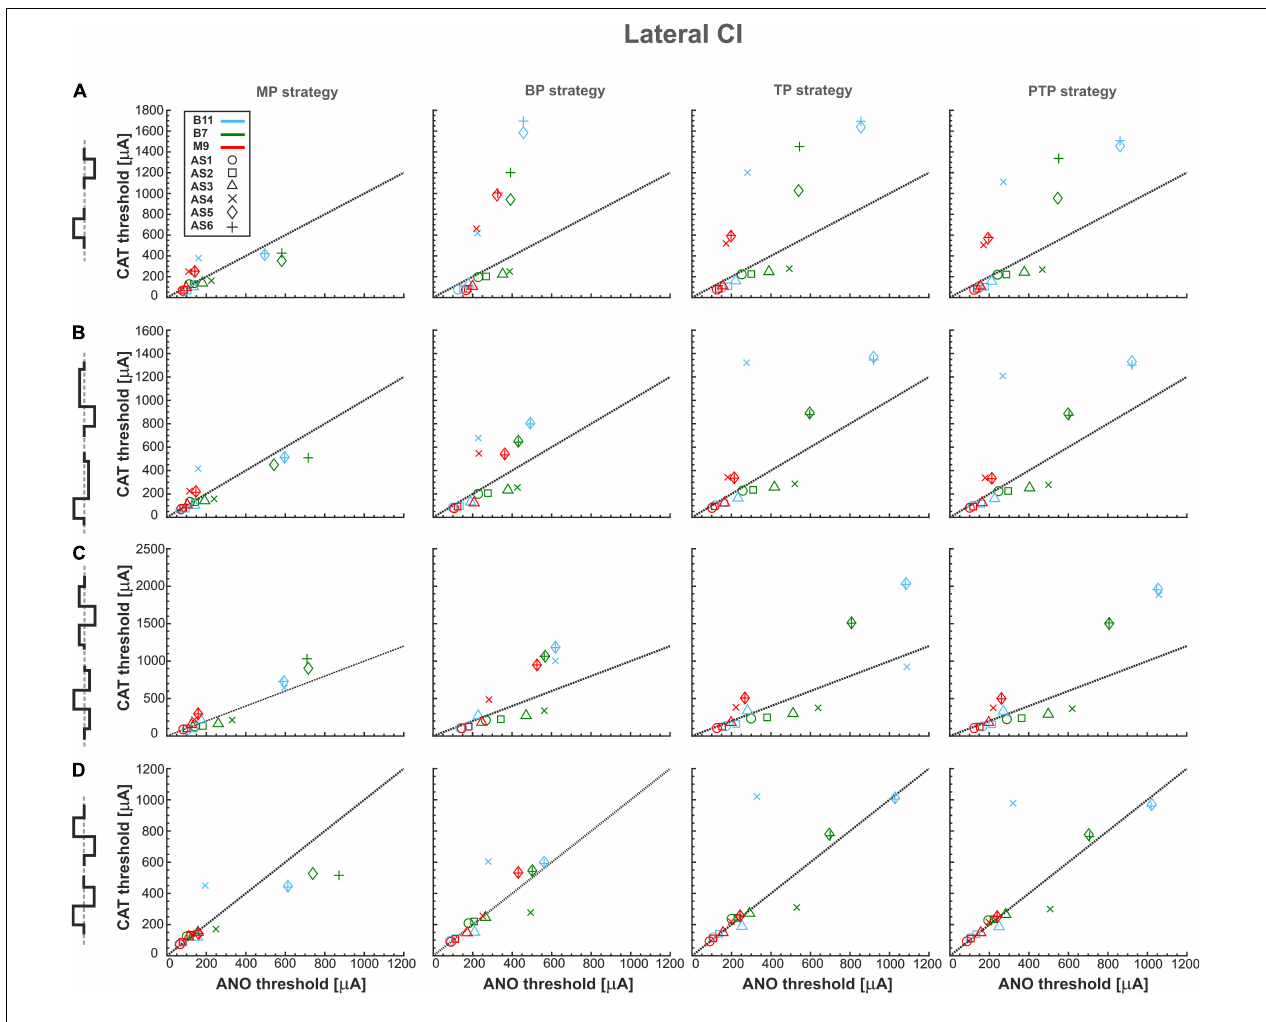
FIGURE 6 | Threshold profiles of three TNs for lateral CI. Layout as in Figure 4 .